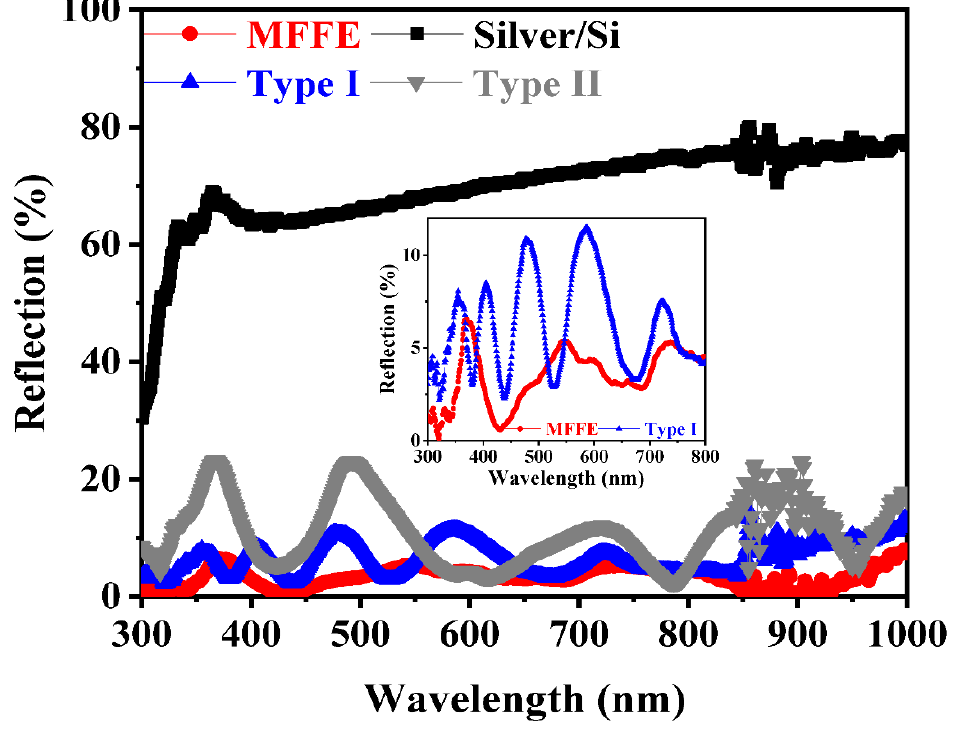
Figure 4. The measured optical reflection through the optical integrating sphere system. The MFFE provides the lowest optical reflection from incident light wavelength of 300 nm to that of 1000 nm. band light harvesting in MFFE without anti-reflection structure over silver